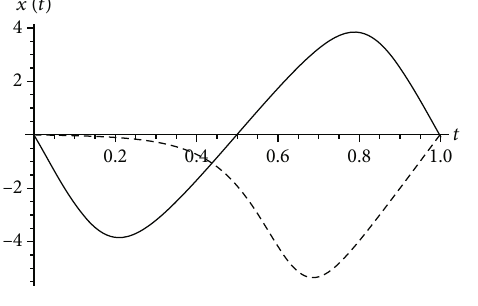
Figure 14: Graphs x ′ ð t Þ for solutions of problems (15) and (37), x α ≈ 0 : 79 , x α ≈ 1 : 4115 (dashed).